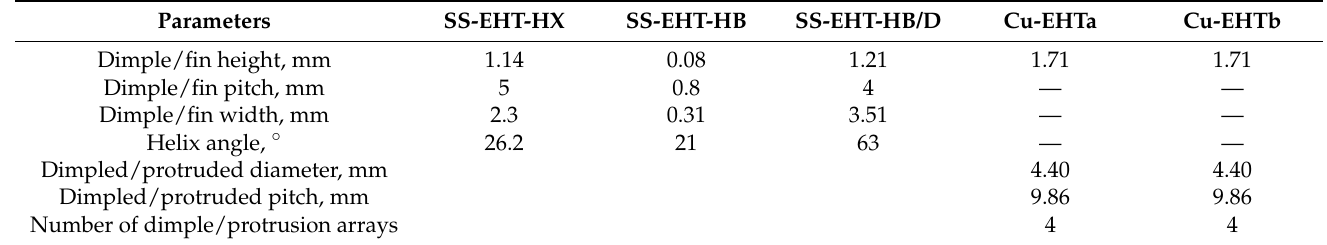
Table 1. Physical measurements of the enhancement patterns used in the various